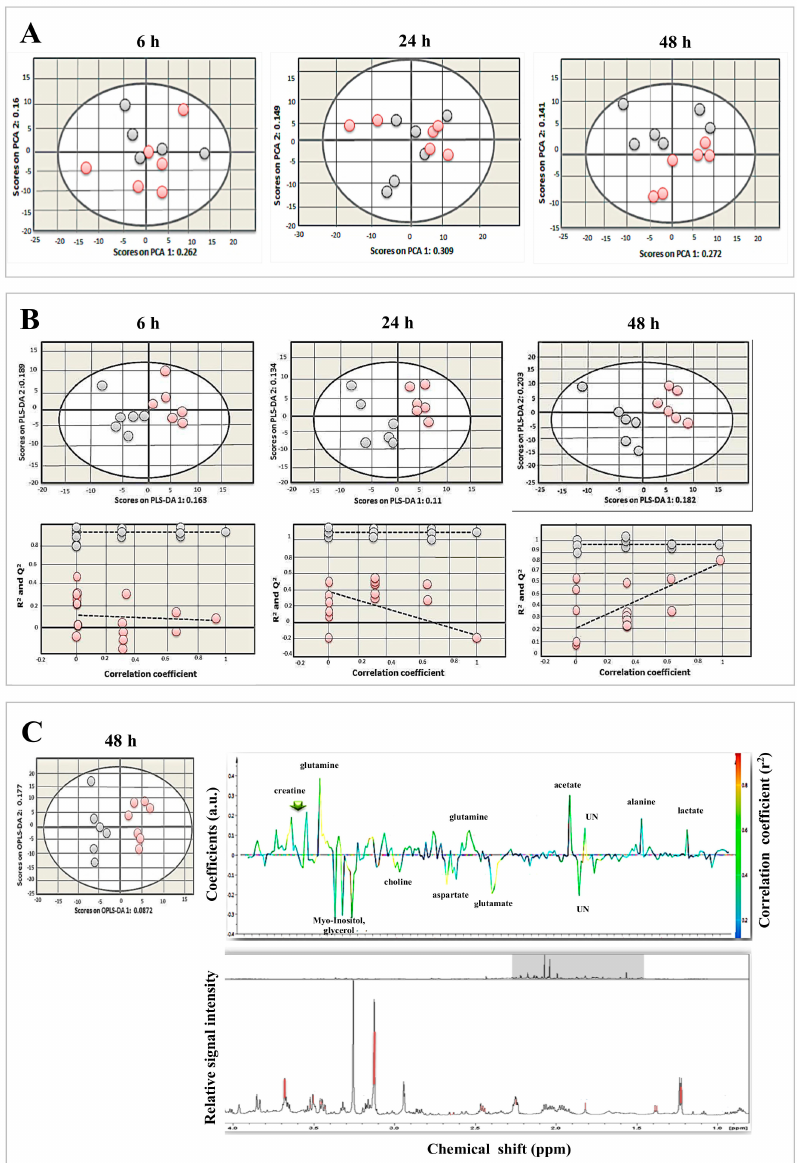
Figure 7. Metabolomic profiling revealed distinct changes in metabolites between T. gondii -infected and control cells. ( A ) PCA score plots of metabolites of infected and uninfected BMECs at 6, 24, and 48 hpi. Infected cells were slightly separated from uninfected cells along PC1 ( R 2 X = 0.262, 0.309, and 0.272 for 6, 24, and 48 hpi, respectively). Each point in the plot represents one replicate 1 H NMR spectra. Gray and red circles denote control and infected samples, respectively. ( B ) PLS-DA score plots (top row) and cross-validation plots (bottom row) of the metabolites. Infected BMECs were separated from uninfected cells along PLS-DA ( R 2 X = 0.163, 0.11, and 0.182 at 6, 24, and 48 hpi, respectively). ( C ) OPLS-DA score plots (left) and corresponding coe ffi cient loading plots (right) derived from 1 H NMR spectra of infected and uninfected cells at 48 hpi. Infected cells were separated from uninfected cells along OPLS-DA 1 ( R 2 X = 0.0872). The color scaling map on the right-hand side of the coe ffi cient loading plot shows the significance of metabolite variations between infected and uninfected cells. Peaks oriented upward (positive direction) and downward (negative direction) indicate metabolites that are more or less abundant, respectively, in infected cells compared to control cells. The red and blue colors denote increased and decreased levels of metabolites, respectively. The peak height is expressed in arbitrary units (a.u.) relative to the total peak contribution. UN indicates unknown